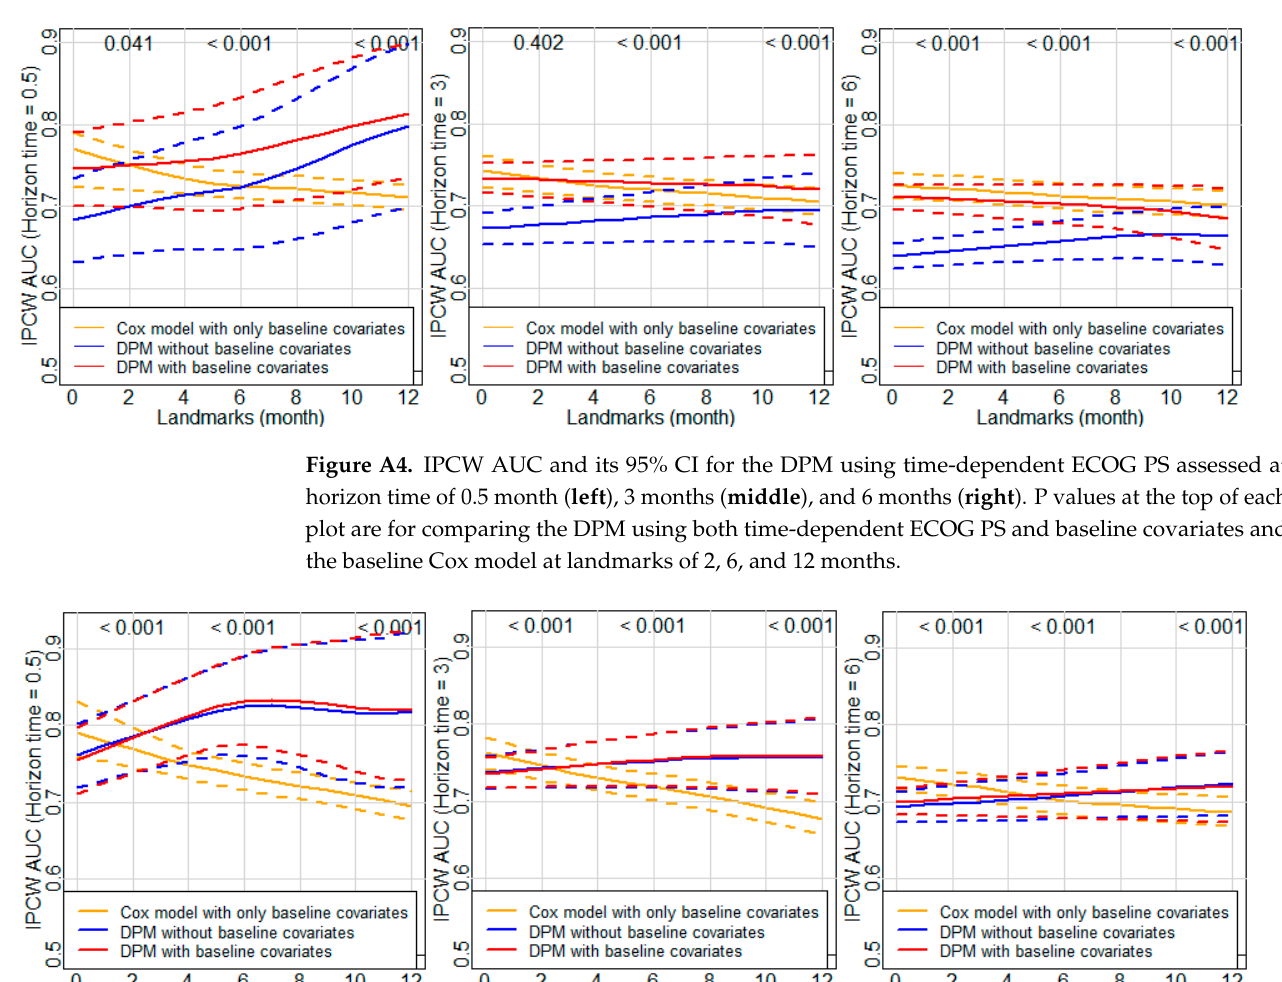
Figure A3. IPCW AUC and its 95% CI for the DPM using time-dependent albumin assessed at horizon time of 0.5 month ( left ), 3 months ( middle ), and 6 months ( right ). P values at the top of each plot are for comparing the DPM using both time-dependent albumin and baseline covariates and the baseline Cox model at landmarks of 2, 6, and 12 months.